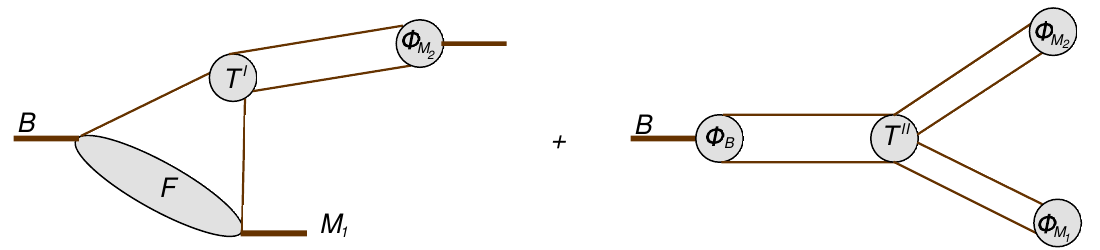
Figure 1 . Factorization of matrix elements for B meson decays into \light"-\light" mesons (both diagrams included) and \heavy"-\light" (only left diagram) in